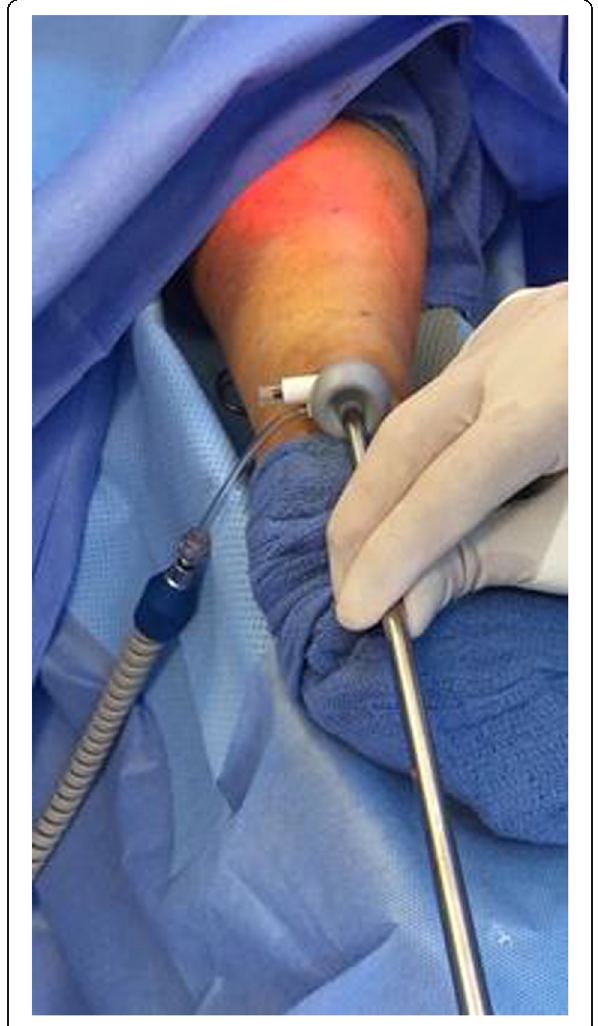
Fig. 1 The endoscopic port with the conical tip inserted in the